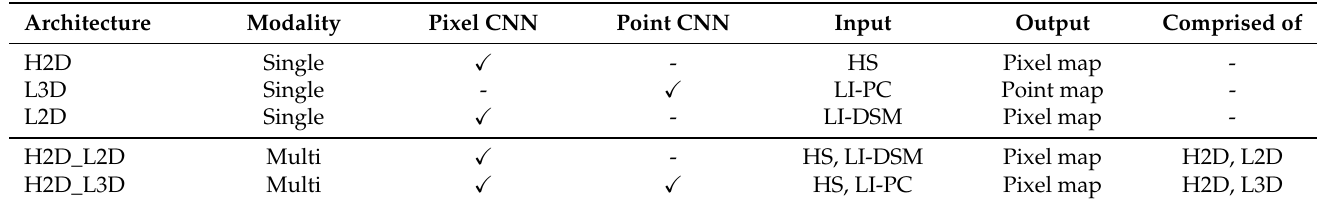
Table 1. Overview of all constructed architectures and their